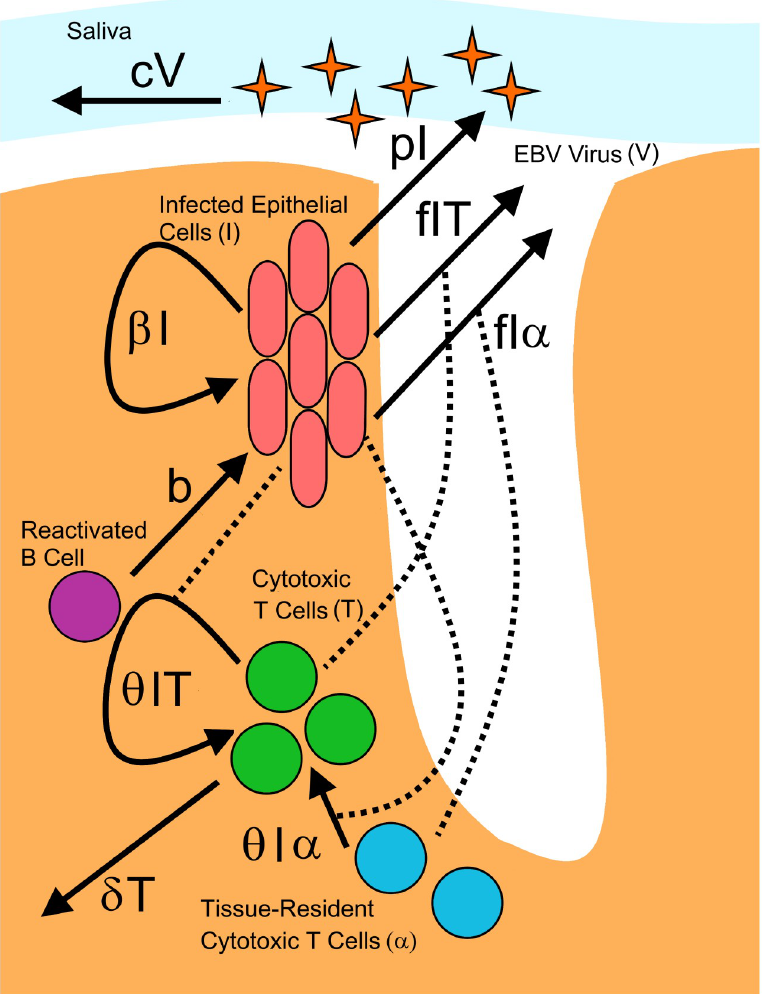
Fig 3. Description of single crypt dynamics. Waldeyer’s ring is represented as a series of 240 individual crypts in which infection dynamics occur. Within each crypt, the population dynamics of infected epithelial cells (I), cytotoxic T cells (T) and EBV (V) are described. The viral load detected in saliva is represented by the total virus aggregated across all crypts. detailed information about Waldeyer’s ring is known, the total surface area of Waldeyer’s ring would be 3540 cm 2 . While epithelial cell densities within tonsils have not been measured, a previous estimate of epithelial cell densities in the genital tract where herpes simplex lesions can form is 1.7 × 10 6 /cm 2 [35]. Assuming similar cell densities in the tonsils, this would indi- cate that a total of 6.1 × 10 9 epithelial cells are present in Waldeyer’s ring. With the production rate of virions per day per cell likely around 10 4 [10, 24], and maximum viral loads seen in cohort participants being just under 10 10 (Fig 1), this would indicate that at most, 10 6 infected cells would be needed to produce the viral loads seen in participants. As our estimates for the total number of epithelial cells within Waldeyer’s ring are multiple orders of magnitude larger than this, it is unlikely target cell number would ever be a limiting factor. Epithelial infection causes the recruitment and proliferation of EBV-specific cytotoxic T cells, T , at a per-capita rate θI . Cytotoxic T cells kill infected epithelial cells following the law of